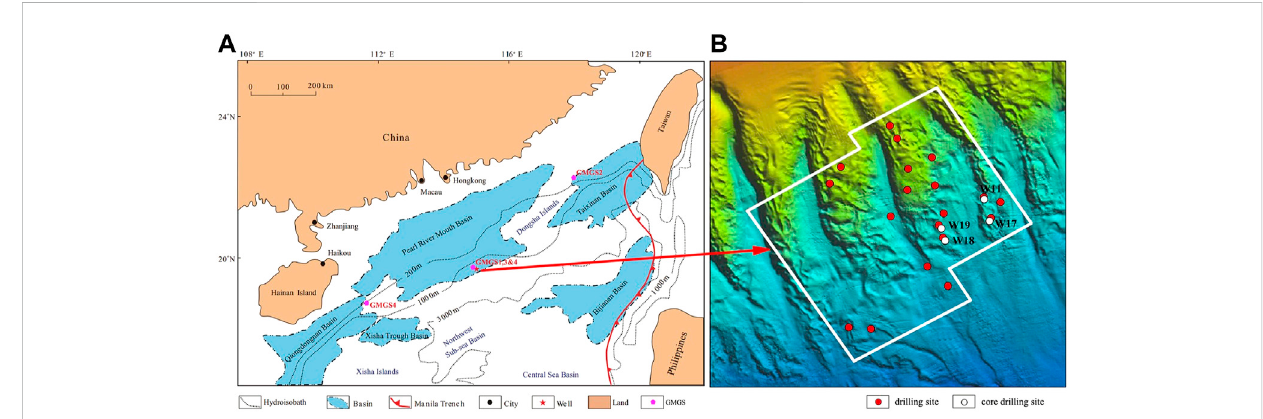
FIGURE 1 SHSC-4 Well location (A) . GMGS3 Subsea topography and drilling locations (B) (Sun Y. et al.,